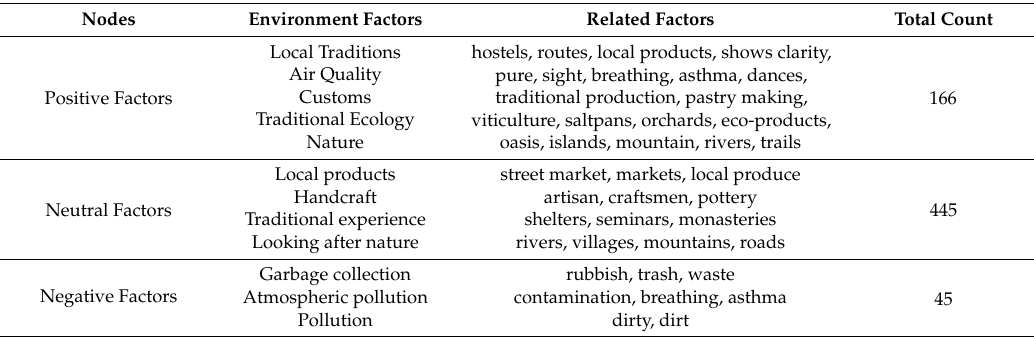
Table 14. Results of N 4 for environment factors identification.